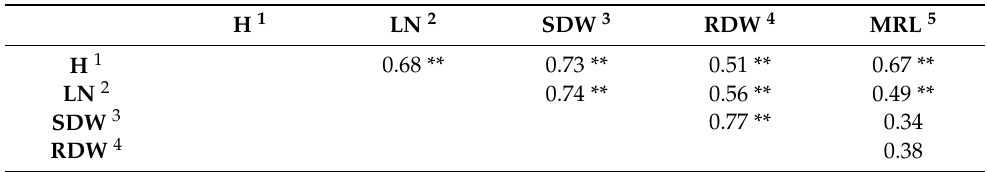
Table 4. Pearson’s correlation between the growth parameters for the studied species at the different doses of the tested compost.